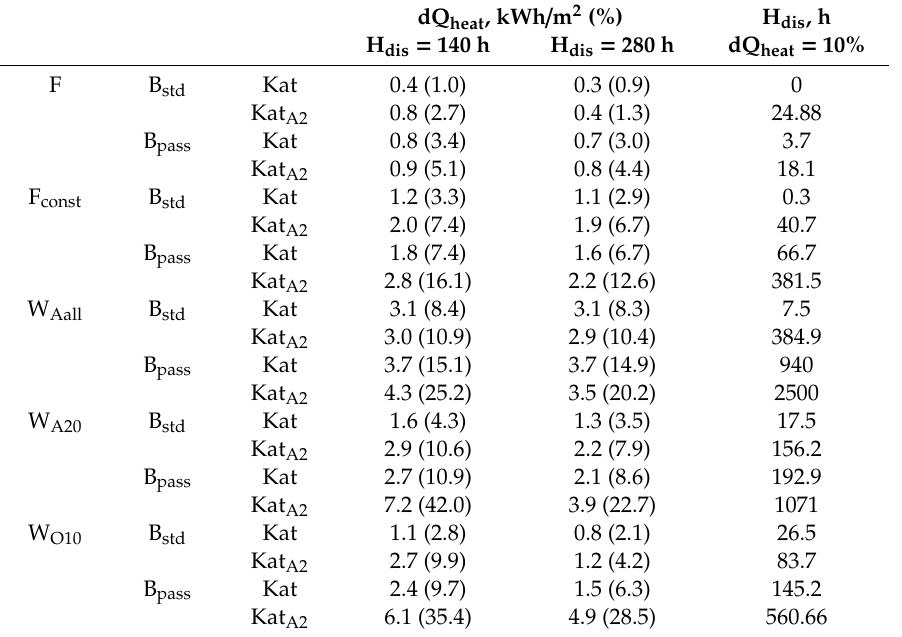
Table 5. Increase in heating demand dla H dis = 140 h and H dis = 280 h. H dis for heating increase dQ heat =